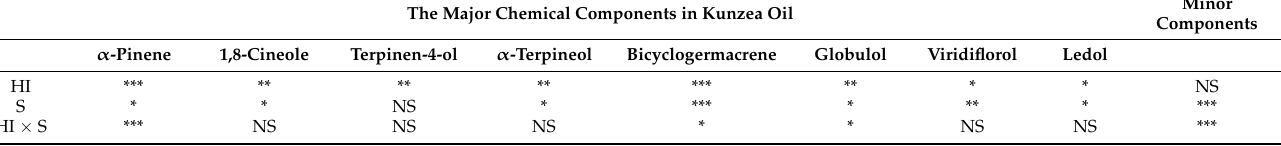
Table 4. The major and minor chemical components in kunzea oil (%) from two-way ANOVA with initial harvest intensity (HI), season (S) and their interaction (HI × S) as variability factors.